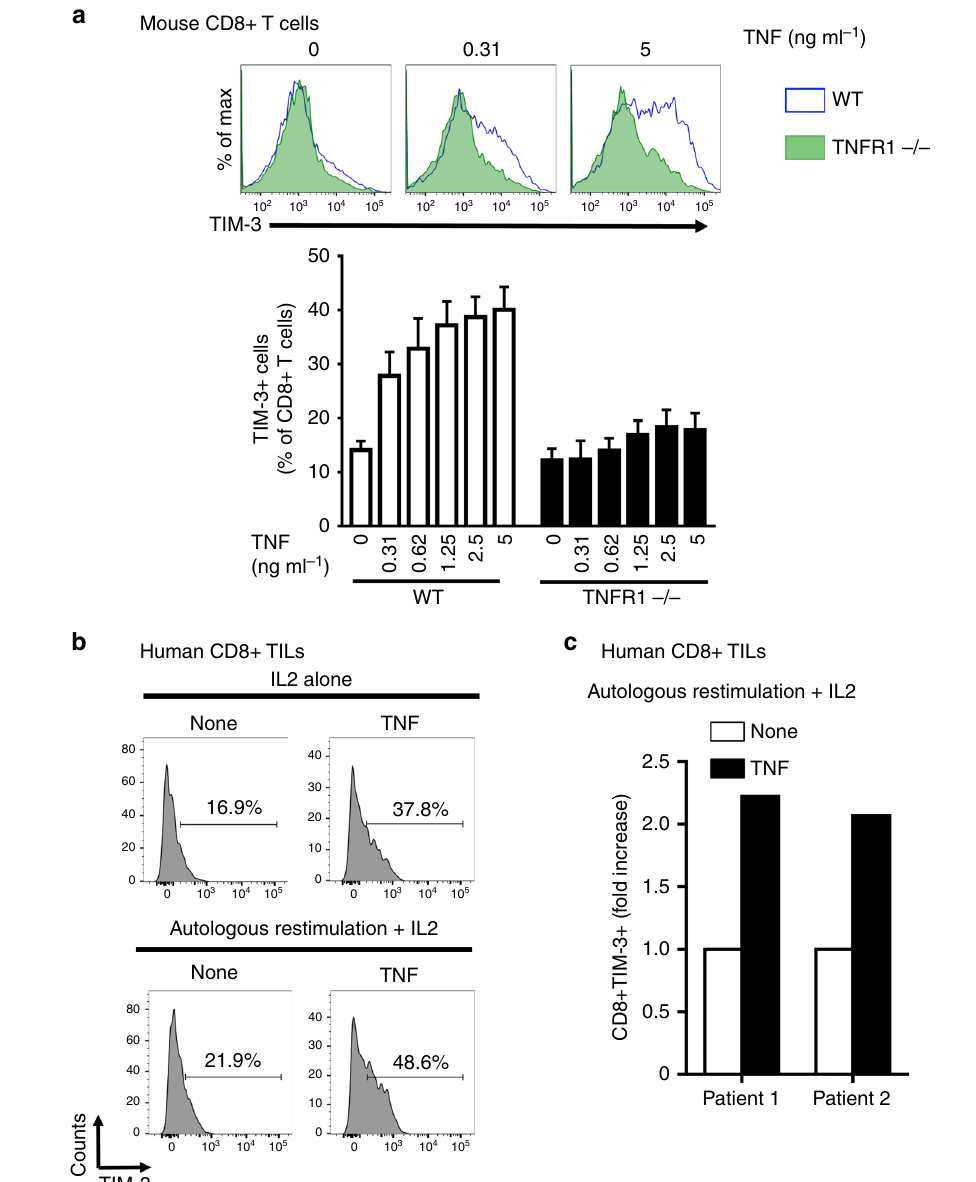
Fig. 4 TNF induces TIM-3 expression on CD8+ T cells ex vivo. a WT or TNFR1-de fi cient CD8+ T cells were incubated with murine TNF for 2 days. TIM-3 expression was next analysed by fl ow cytometry. Upper panels: representative histograms. Lower panel: data are means ± s.e.m. of three independent experiments. b and c TILs from two human metastatic melanoma patients were cultured with or without autologous melanoma cells for two days in the presence 200 U ml − 1 IL-2 +/ − 50 ng ml − 1 human TNF. TIM-3 expression was next analysed by fl ow cytometry: histograms showing TIM-3 staining on TILs from patient 1 ( b ); bar graph depicting the fold increase in TIM-3 expression on TILs from patients 1 and 2 ( c